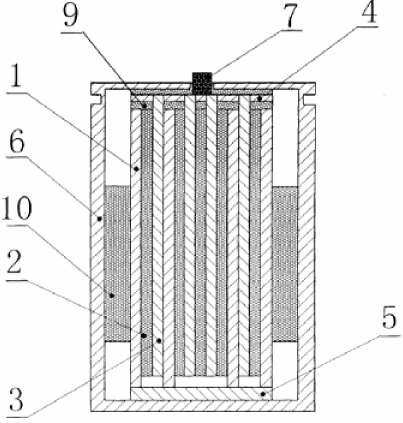
Figure 23. Schematic diagram of a high-power cell with 1: negative electrode, 2: separator, 3: positive electrode, 4: positive current collection, 5: negative current collector, 6: can, 7: cap, 9: insulator, and 10: insulator